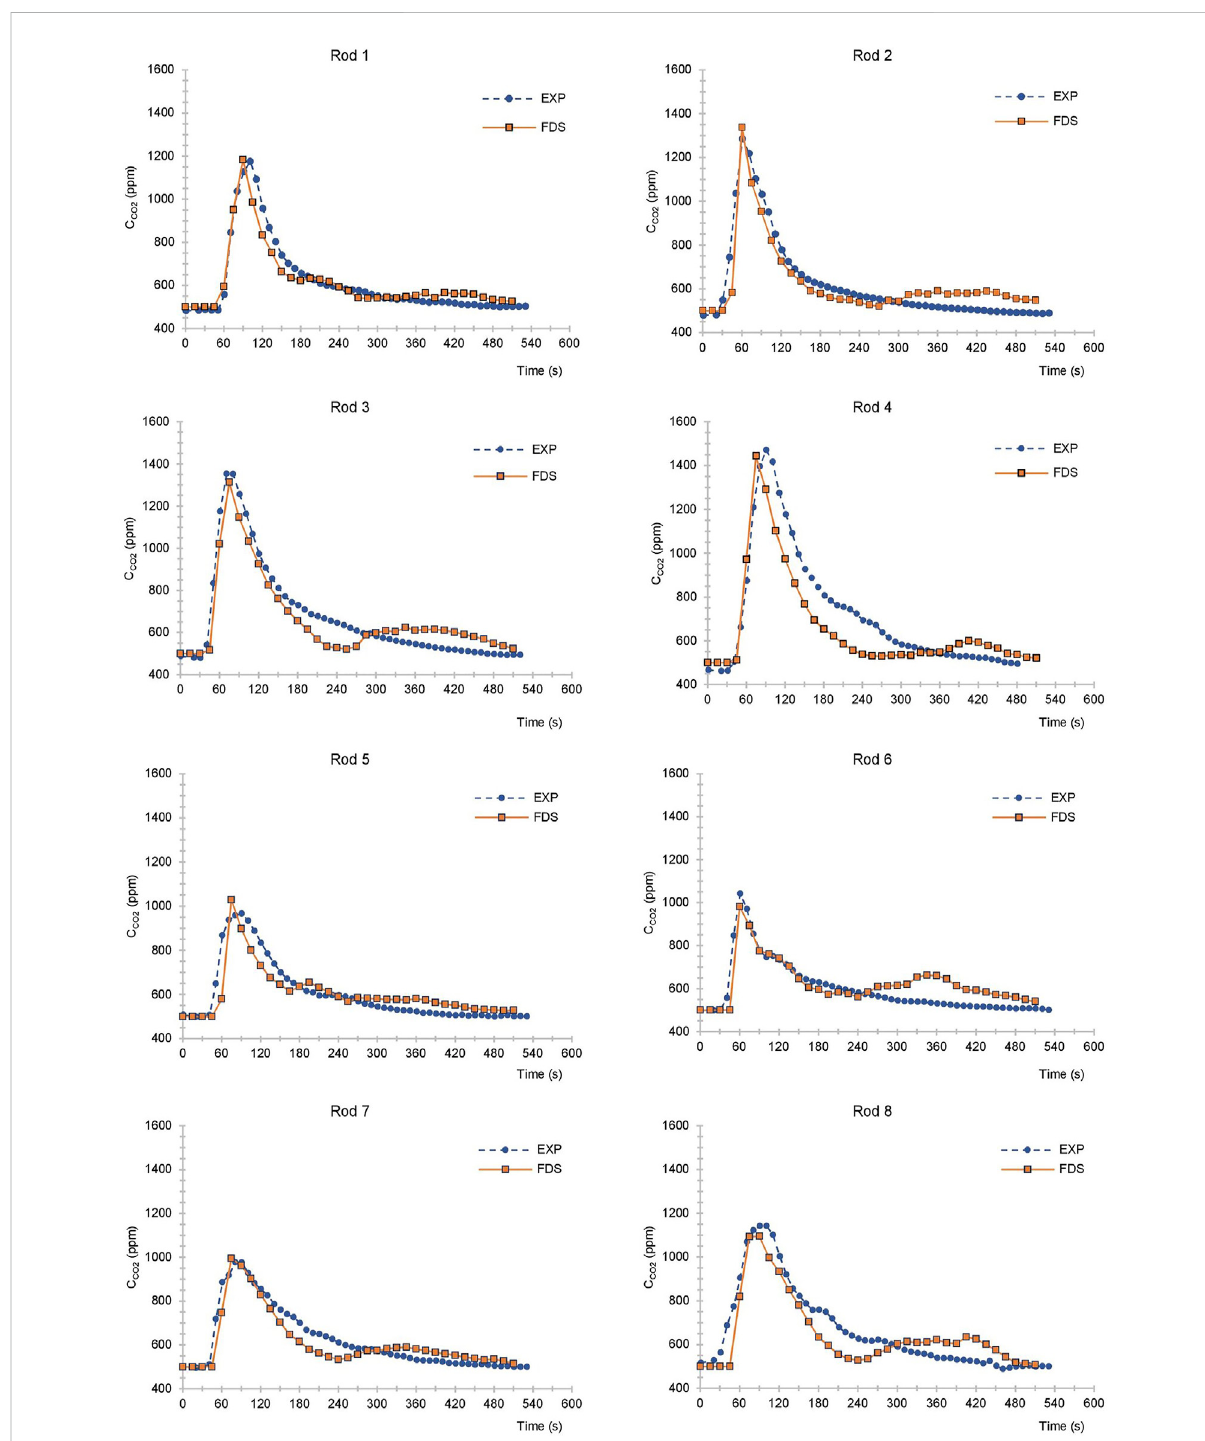
FIGURE 6 Experimental data and numerical curves of tracer gas (CO 2 ) tests (rods 1 –